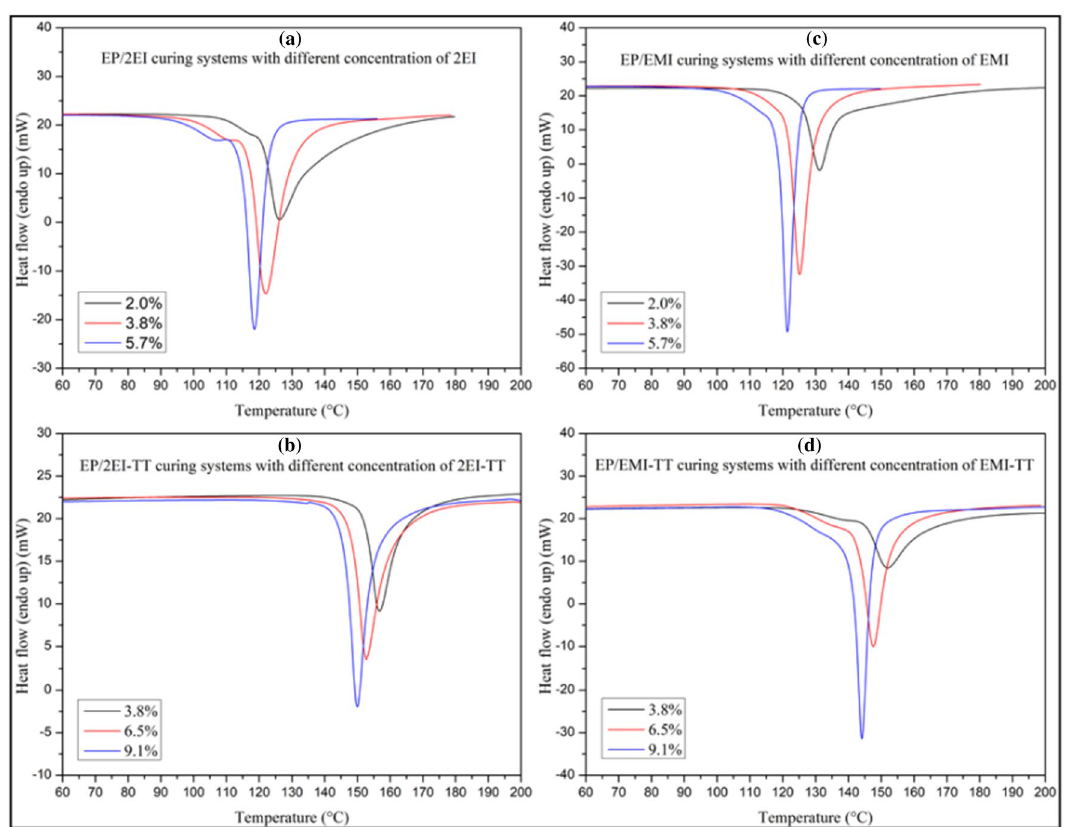
Fig. 5 DSC curves of the EP blends with different ratio of 2EI, EMI, 2EI-TT and